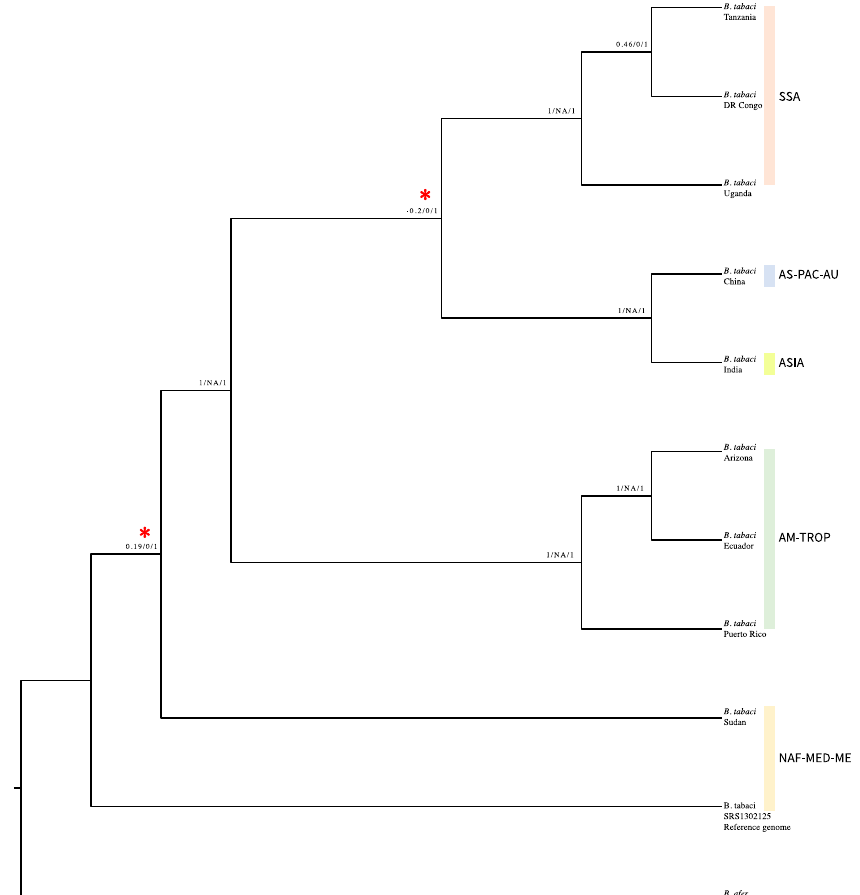
Figure 4. The B. tabaci complex of whiteflies showing the results of quartet sampling (QC: quartet concordance (frequency a concordant topology is observed)/QD: quartet differential (scaled fraction of discordant topologies)/QI: quartet informativeness (proportion of replicates that are informative)). Red asterisk indicate nodes of instability as discussed in the text. Nodes represented by 1/NA/1 are most stable and no discordant topologies are detected across quartets sampled (QD = NA).